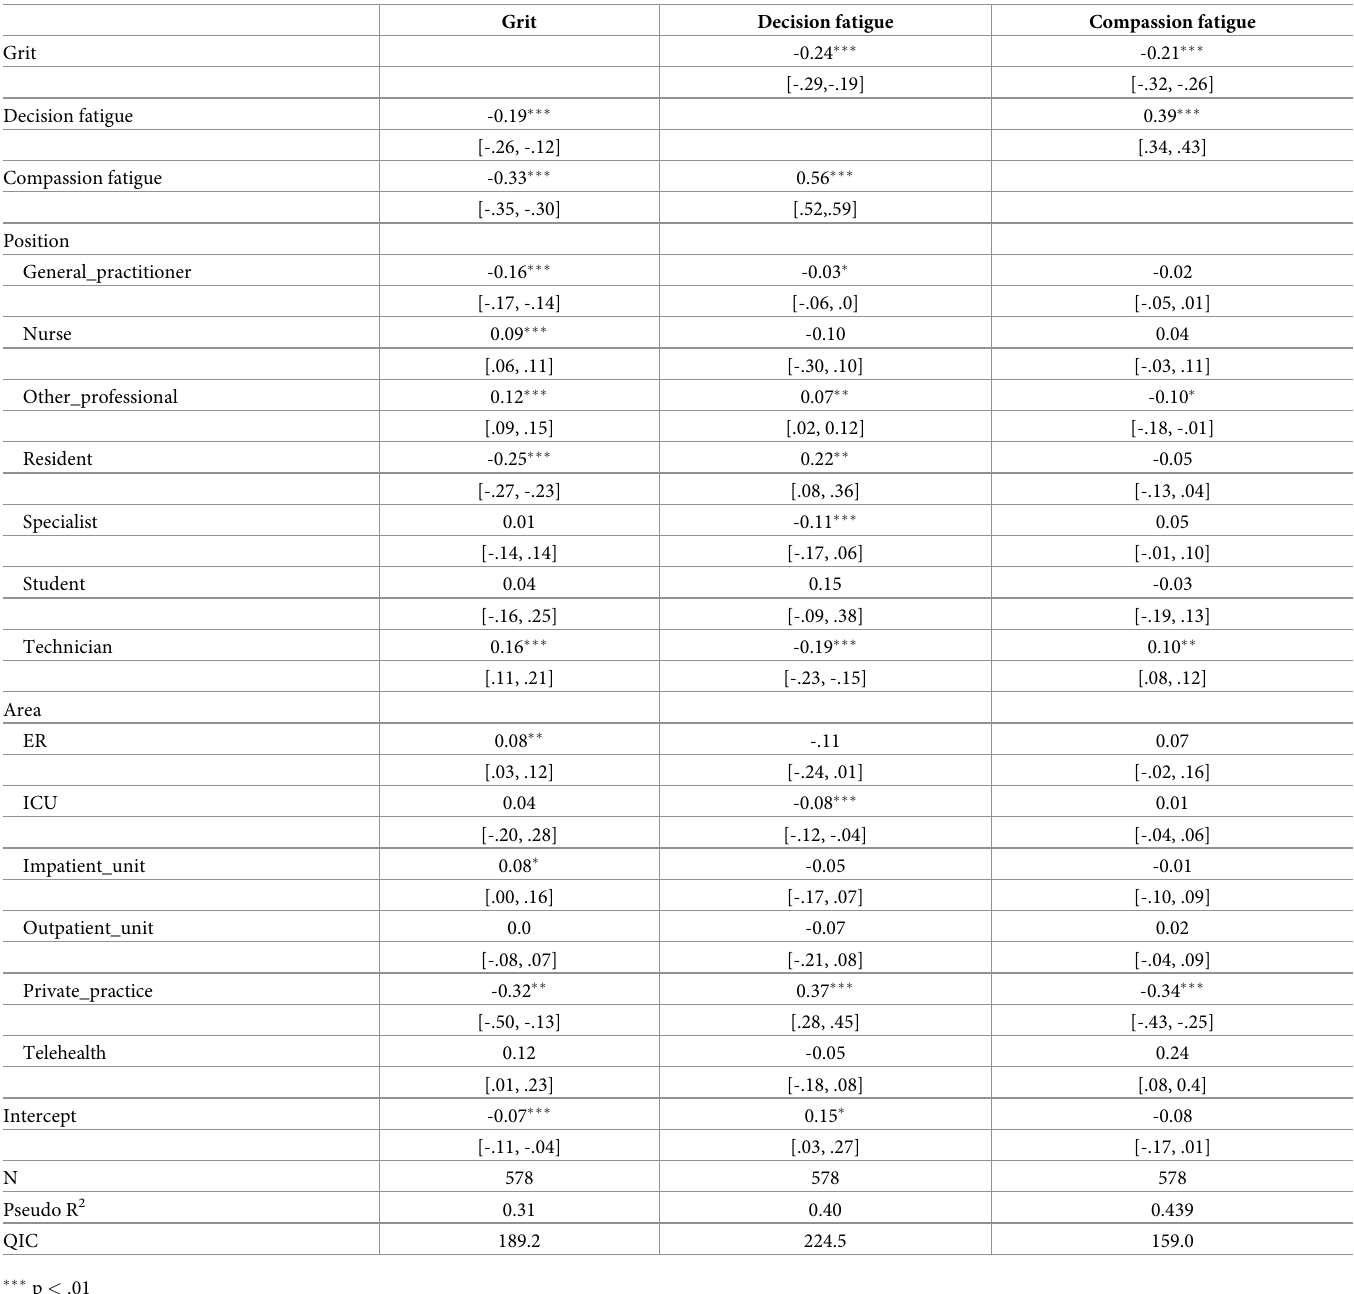
Table 3. Generalized estimated equations-based linear models